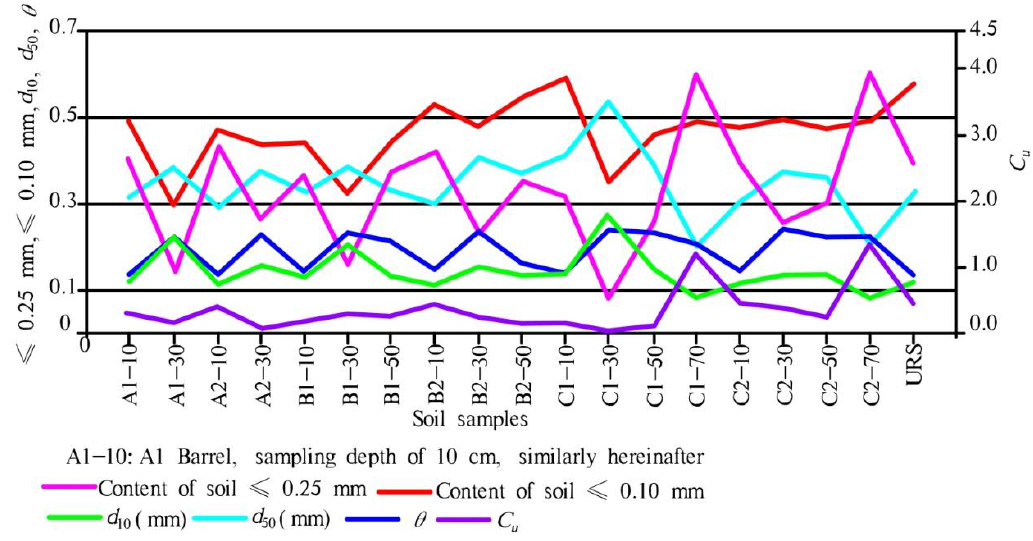
Figure 17. Scatter plot with straight lines of percentage content of soils ≤ 0.25 mm and ≤ 0.1 mm, d 10 , d 50 , C u , and θ .